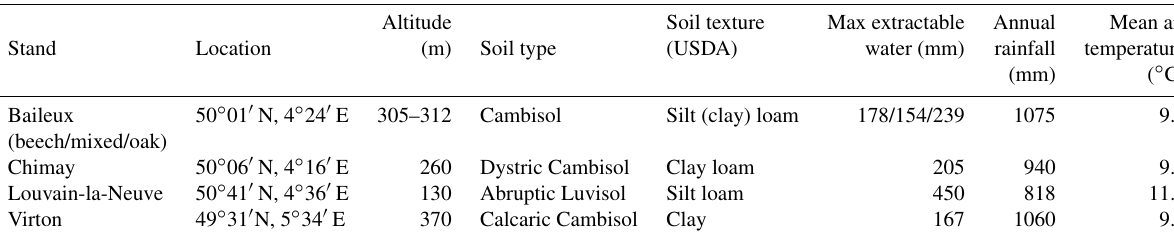
Table 3. Soil and meteorological characteristics of the different study sites (2001–2016 period). Altitude Soil